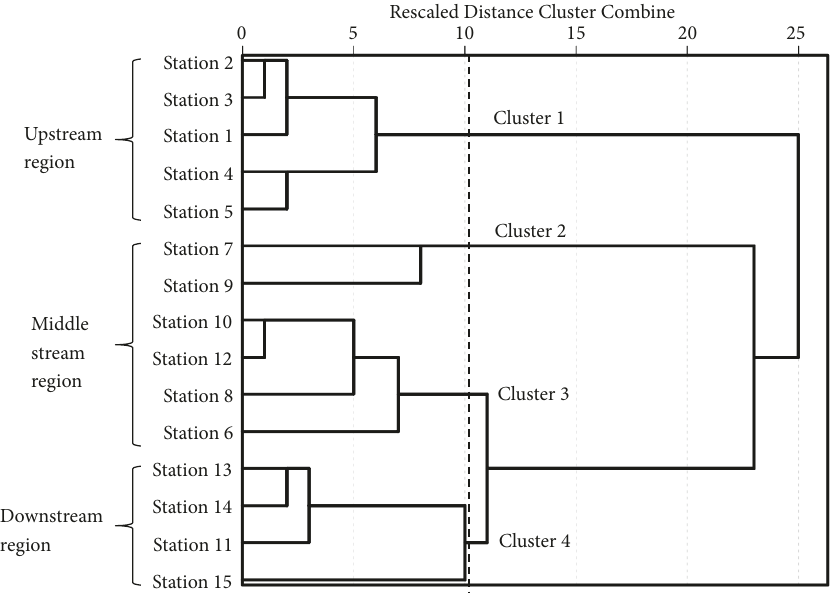
Figure 2: Dendrogram of the cluster